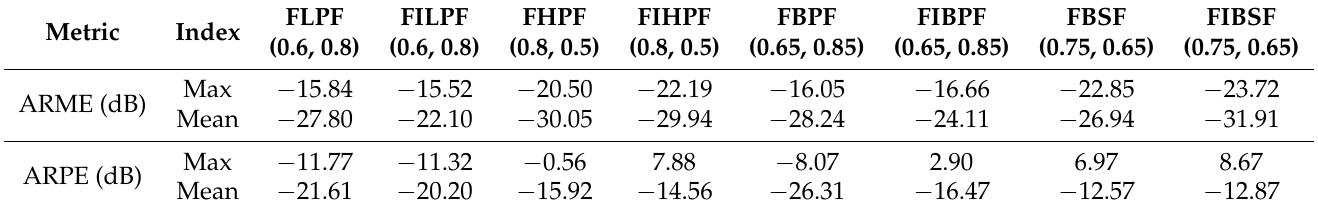
Table 13. ARME and ARPE performances of the SPICE-simulated proposed filters based on nominal values of